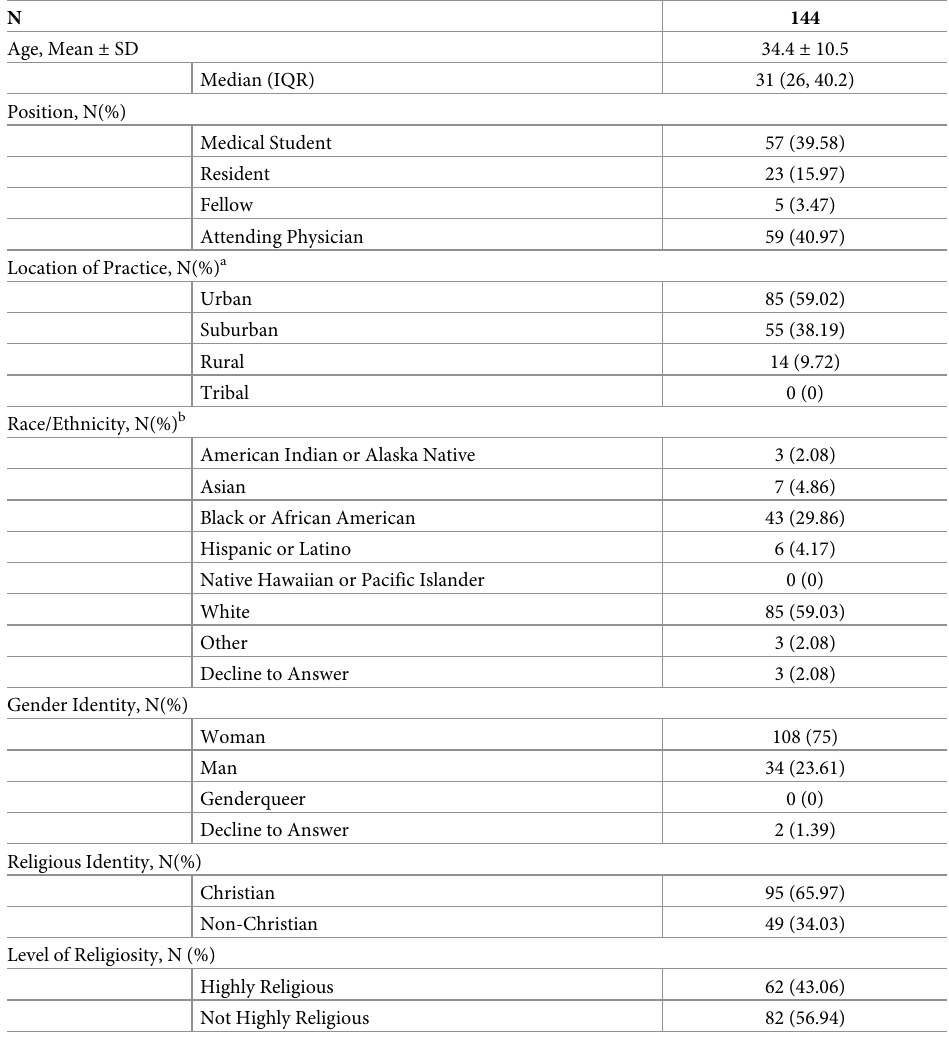
Table 2. Participant